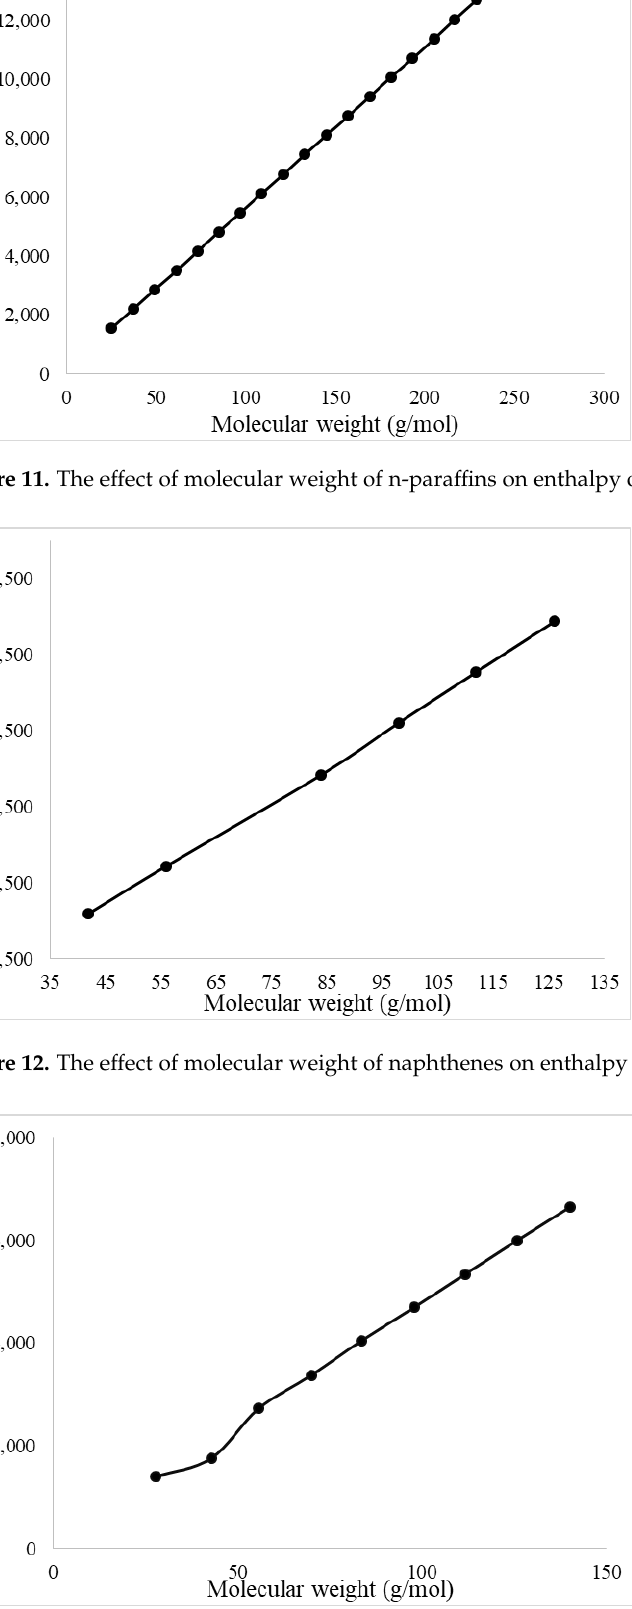
Figure 14. The effect of molecular weight of ketones on enthalpy of combustion .